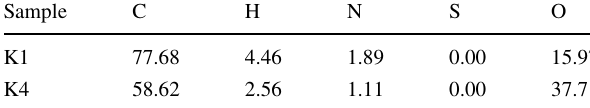
Table 2 Elemental composition of the coal samples Kladno K1 (unaltered coal) and K4 (thermally and oxidatively altered coal) (dry ash free basis)